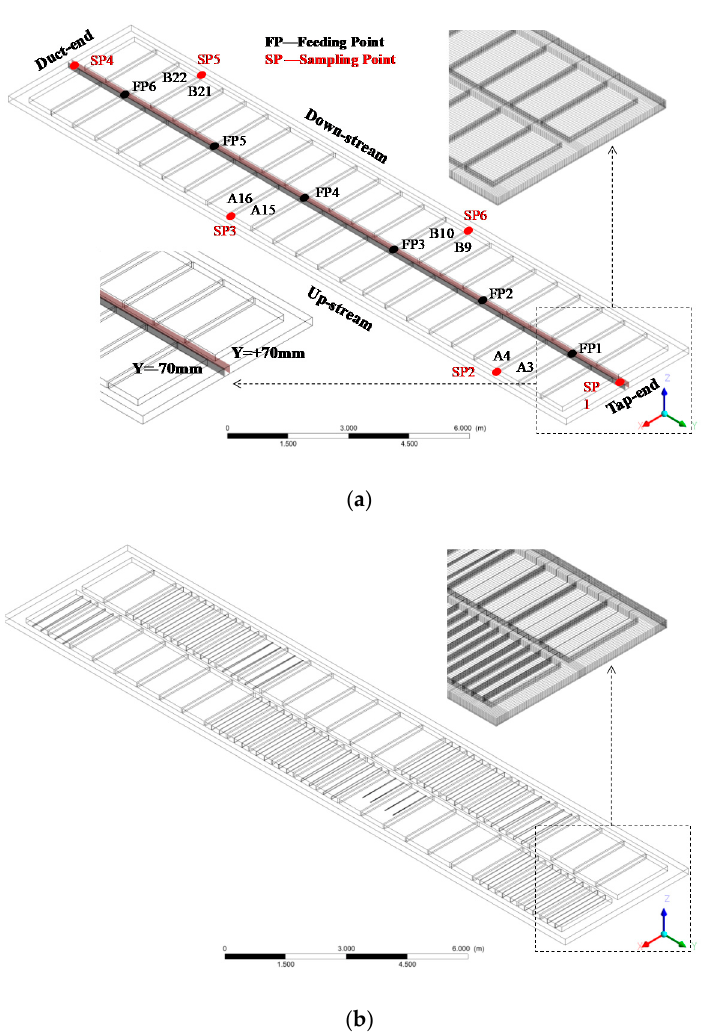
Figure 1. Schematic diagram of geometry, feeding points, and sampling points in a typical unslotted Hall–Héroult reduction cell. ( a ) Unslotted case and ( b ) slotted case. Table 1. Detailed slot configurations and parameters at a critical instant of real cell operation.